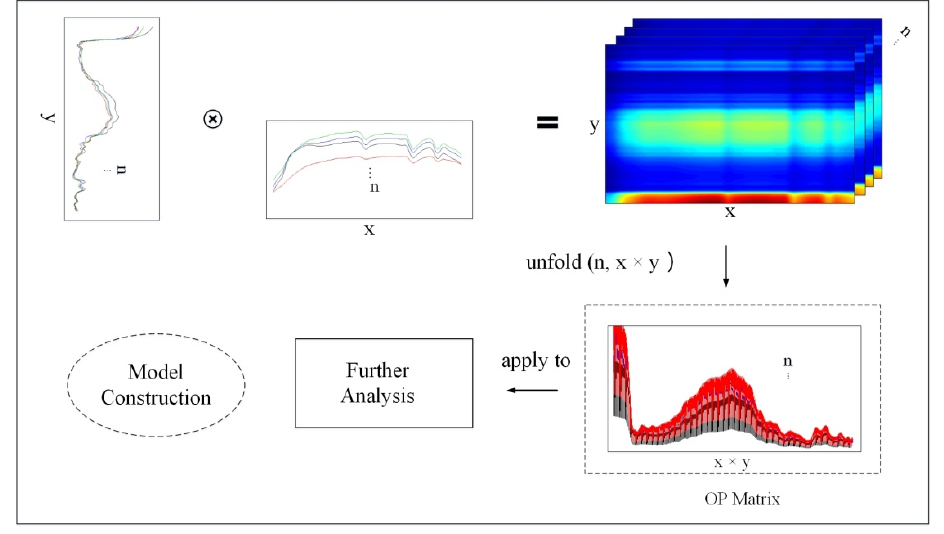
Figure 2. Workflow of data fusion by outer product analysis (OPA) (revised after [27]).